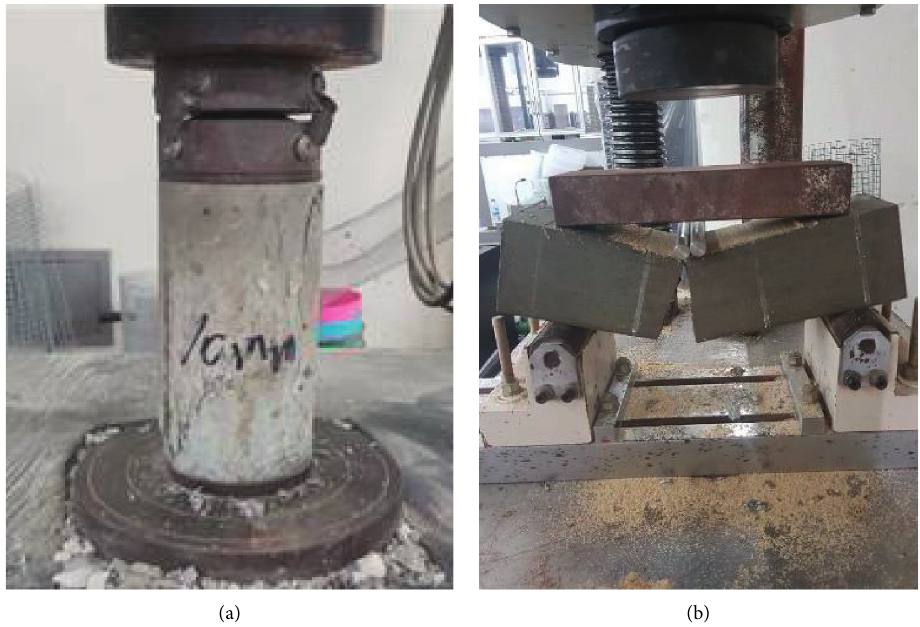
Figure 8: Measurement of (a) compressive and (b) flexural